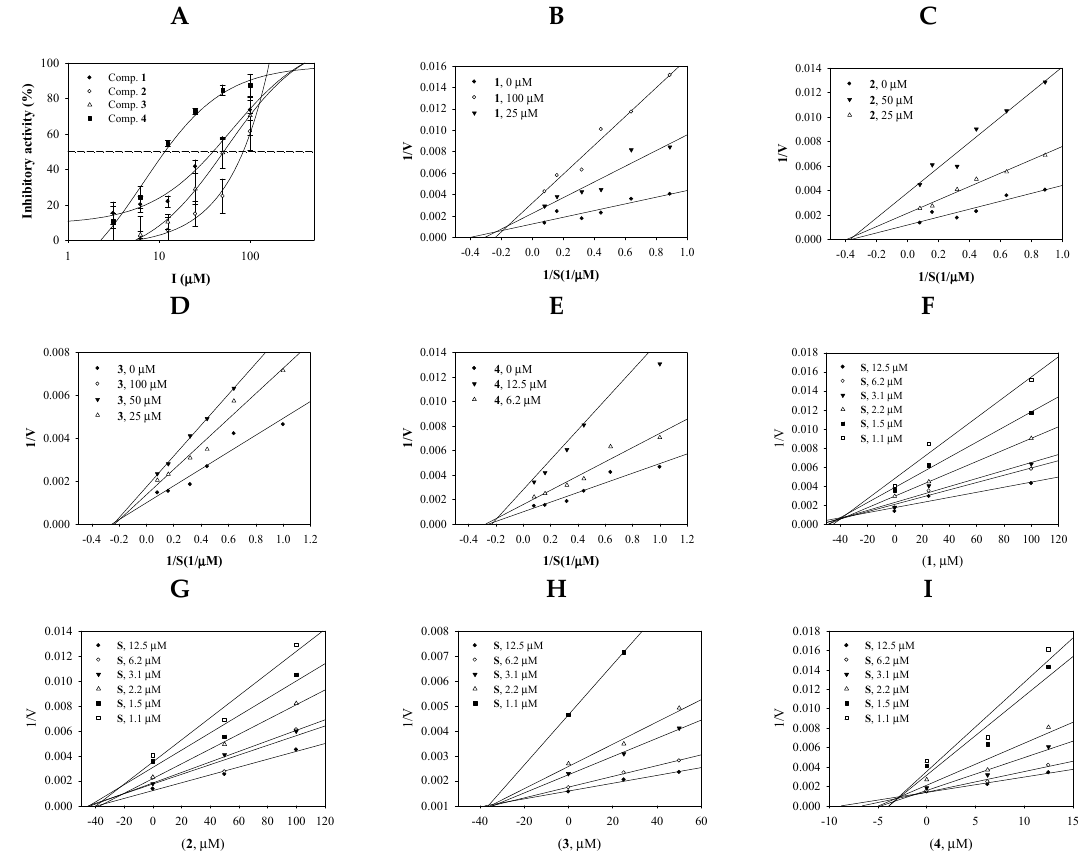
Figure 2 . Inhibitory activities of the inhibitors 1 – 4 at a variety of concentrations toward soluble epoxide hydrolase (sEH) ( A ). Lineweaver-Burk plots ( B – F ) and Dixon plots ( G – I ) for the inhibition of sEH by compounds 1 – 4 . Table 1. The soluble epoxide hydrolase (sEH) inhibitory activities of compounds 1 – 4 . The Inhibitory Activity on sEH